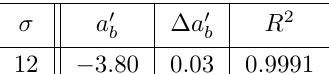
Table 12 . Parameters of the fit (4.5) for σ = 12 and α m = 7 . 5 . ∆ a 0 . R 2 is the R-squared goodness of the fit. a 0 b